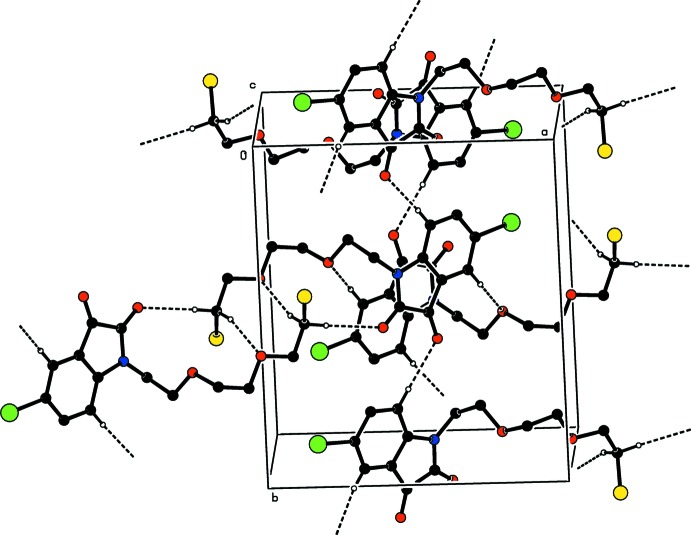
A partial packing diagram, viewed down the c-axis direction. C—HBrmind⋯ODio, C—HBrmind⋯OEthy, C—HChlethy⋯ODio and C—HChlethy⋯OChlethy (Brmind = bromo­indoline, Dio = dione, Ethy = eth­oxy and Chlethy = chloro­eth­oxy) hydrogen bonds are indicated by dashed lines. Only the major component of disorder is shown for clarity.